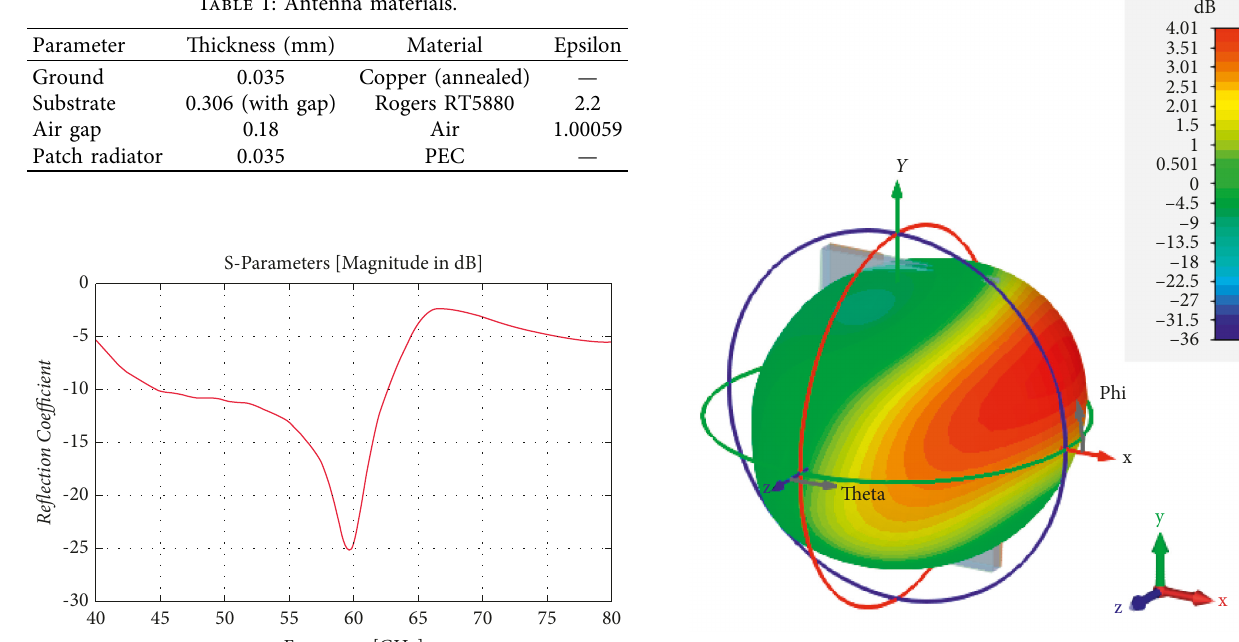
Figure 5: 3D radiation pattern in free space for at60